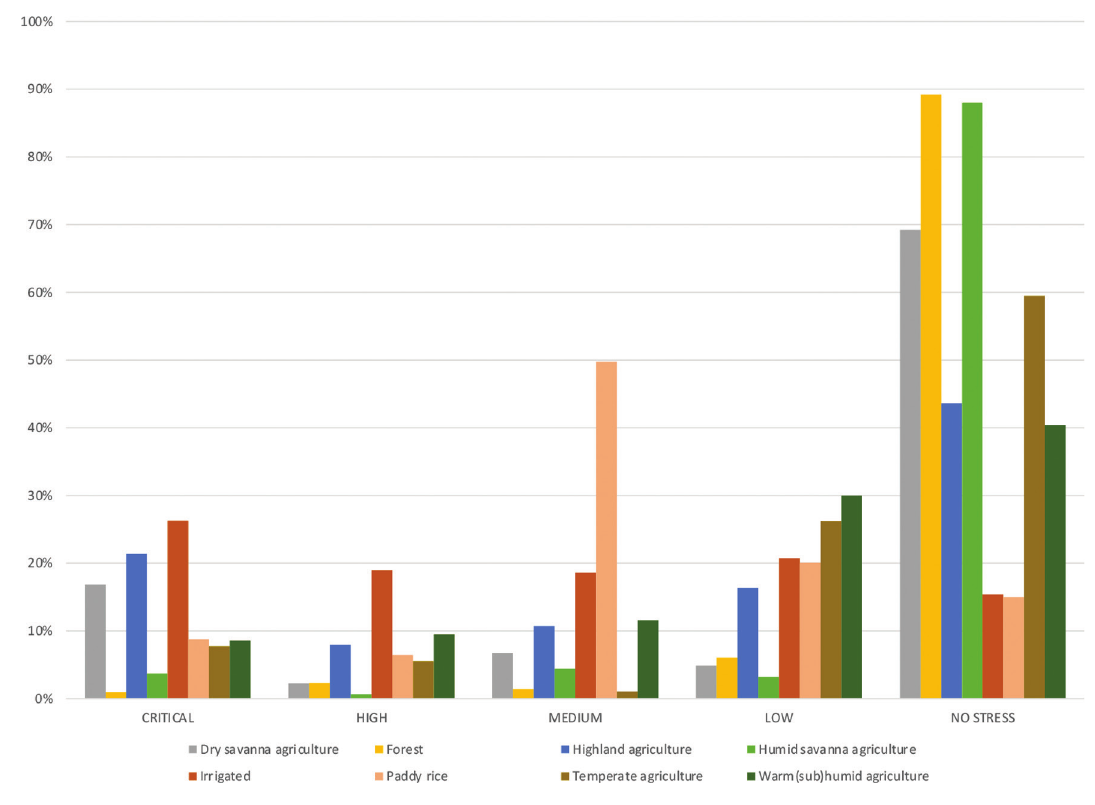
Analysis of the occurrence of some of the major agricultural systems in the classes of water